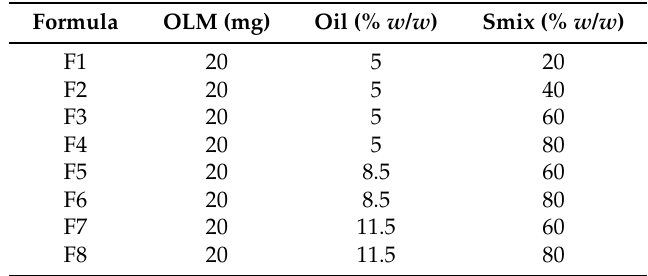
Table 1. Percent w / w Compositions of Optimized OLM Loaded SNEDDS